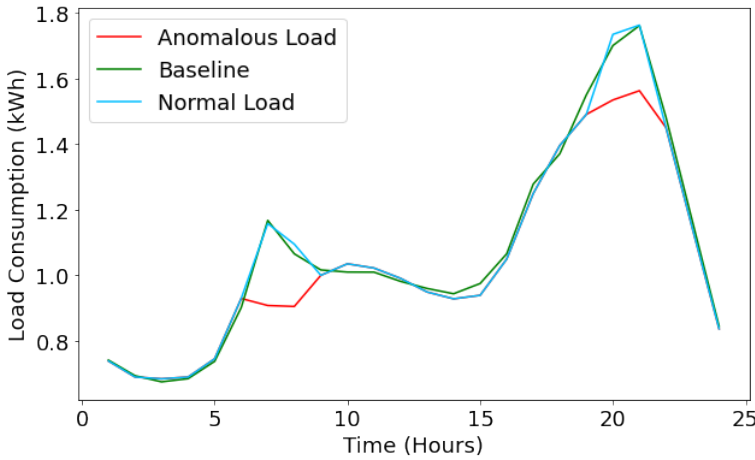
Figure 10. Energy Loss prediction for Basic Facilities.